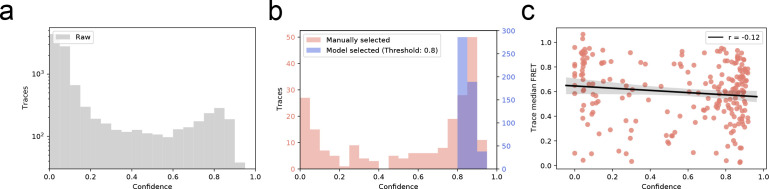
Distribution of trace quality of the experimental dataset.(a) The predicted confidence score of every trace in experimentally recorded dataset (b) Confidence score distribution of manual versus automatic selection of smFRET traces. Automatic selection exclusively accepts high-confidence traces. (c) Pearson’s test displaying no correlation (r = −0.12) between predicted trace confidence and mean FRET in the manually selected dataset.